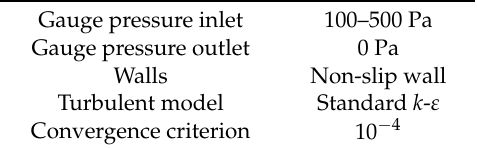
Figure 4. Meshes and boundary conditions of a three-dimensional gas torch. Table 3. Boundary conditions and numerical method.